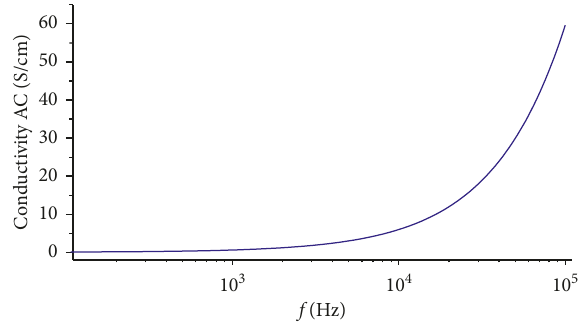
Figure 6: AC conductivity spectra of